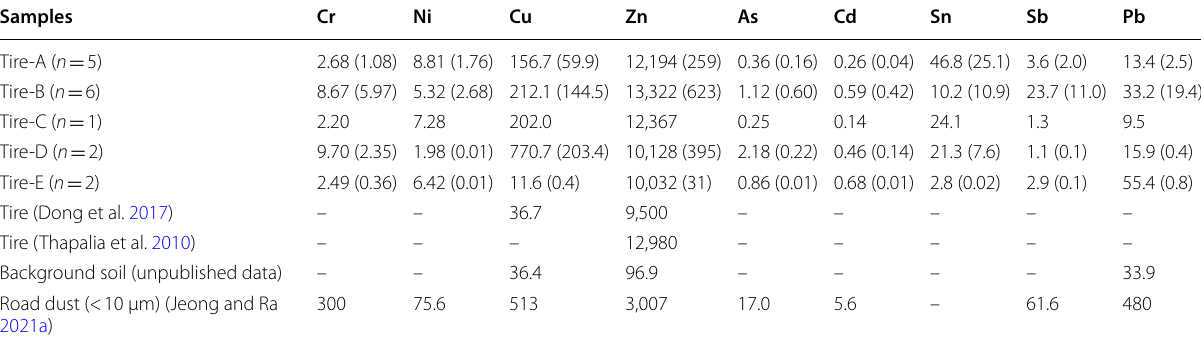
Table 1 Mean (standard deviation in parentheses) of toxic metal concentrations (mg/kg) in tires from different manufacturers and comparisons with published data